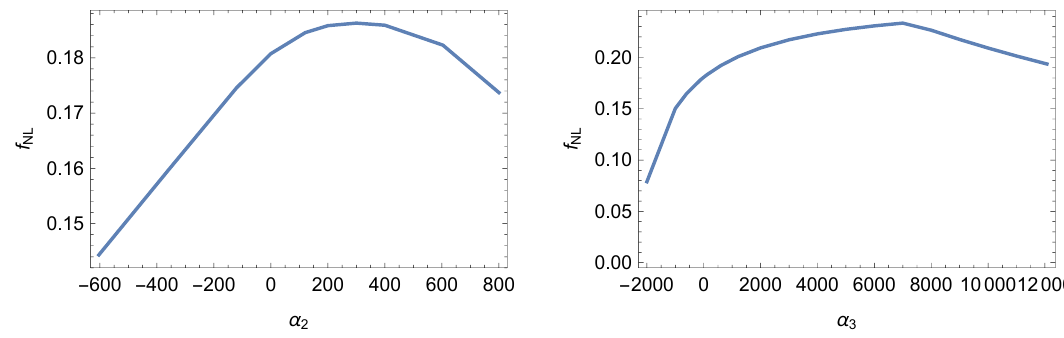
Figure 3 . The e(cid:11)ect of (cid:11) 2 (left panel) and (cid:11) 3 (right panel) on non-Gaussianity for a parameter point taken from (cid:12)gure 1 which is consistent with Planck data and has the largest non-Gaussianity among the set of parameter points in (cid:12)gure 1. Speci(cid:12)cally, here f = 0 : 429 M P , a (cid:0) ; 0 = 0 : 233 M P